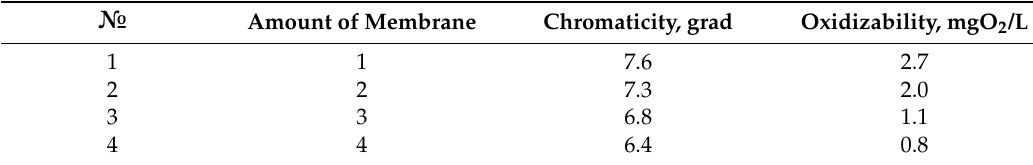
Table 2. The results of purification of natural polluted water from dissolved organic substances. The initial water chromaticity was 22 grads; initial water oxidizability was 4.2 mgO 2 /L; each such membrane used was 3.5 mm thick. The filtration time of 1 L of water through cellulose-carbon membranes was less than 10 min (filtration surface was 200 cm 2 ).